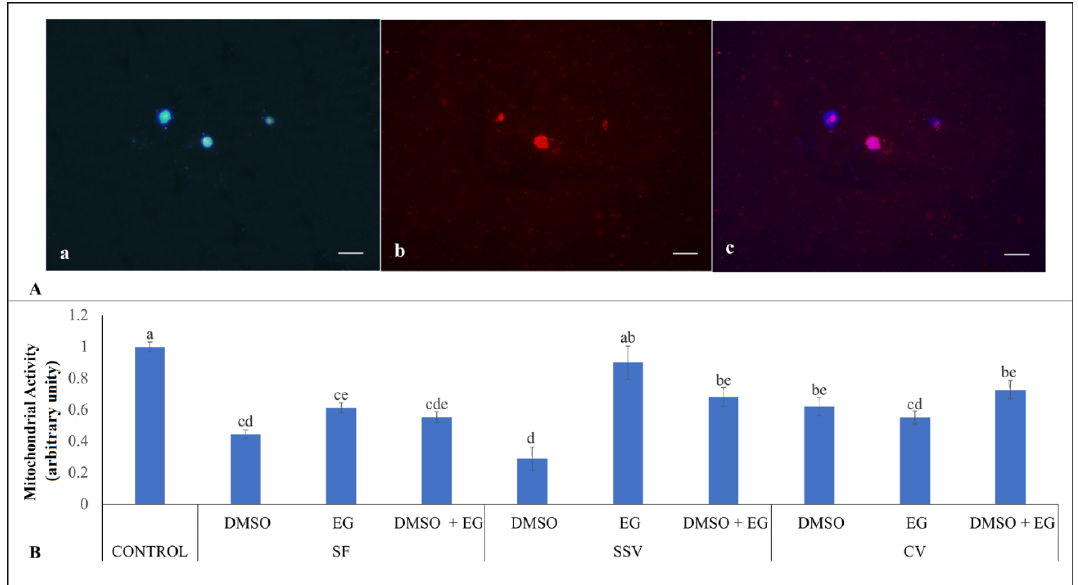
Figure 3. Evaluations of mitochondrial activity (MitoTracher Red staining) in testicular tissues from adult red-rumped agoutis (n = 5) after different cryopreservation treatments. ( A ) Representative images for: ( a ) Hoechst 33342 staining, ( b ) MitoTracher Red staining, ( c ) merged images; ( B ) Average values (mean ± SEM) of arbitrary unities used for the evaluation of mitochondrial activity in testicular tissues exposed to different treatments (slow freezing, SF; conventional vitrification, CV; and solid- surface vitrification, SSV) and different cryoprotectants: dimethyl sulfoxide (DMSO), ethylene glycol (EG), and DMSO + EG. Scale bar: 20 µ m. a–e Different lowercase letters above bars indicate differences among treatments ( p <